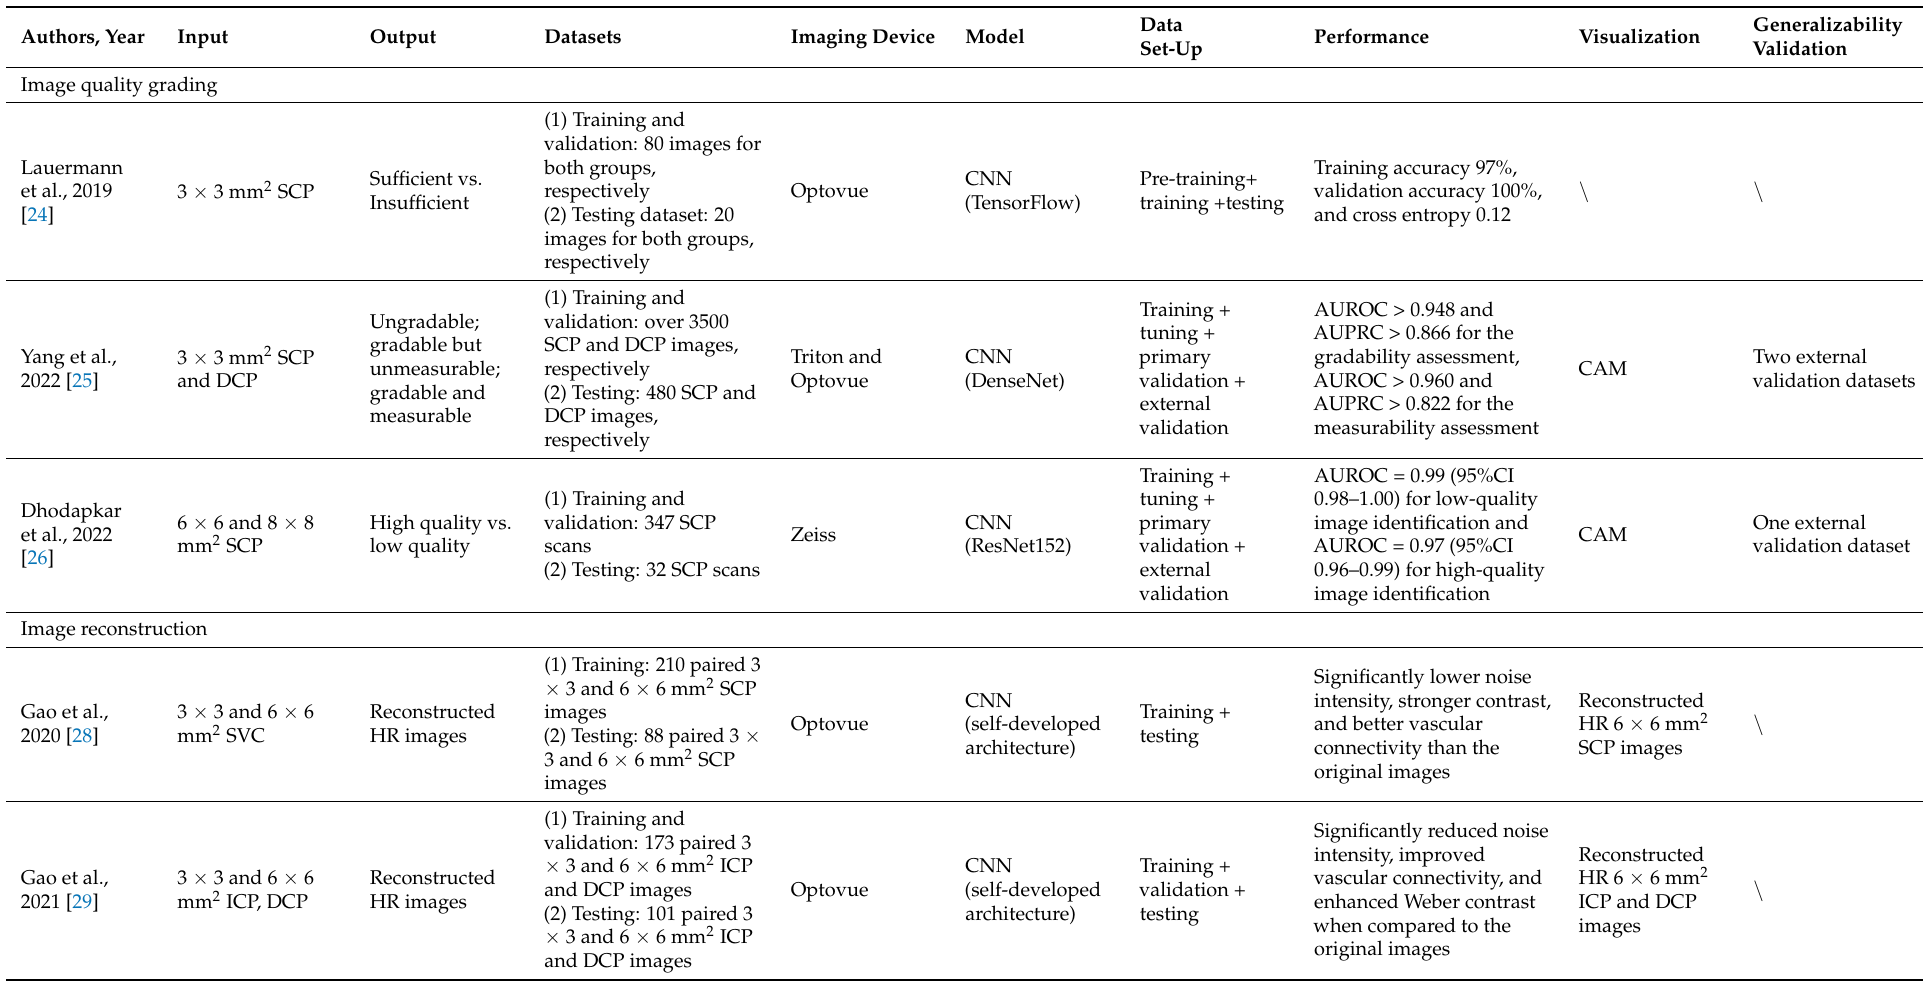
Table 1. Summary of existing deep learning models with the combination of optical coherence tomography